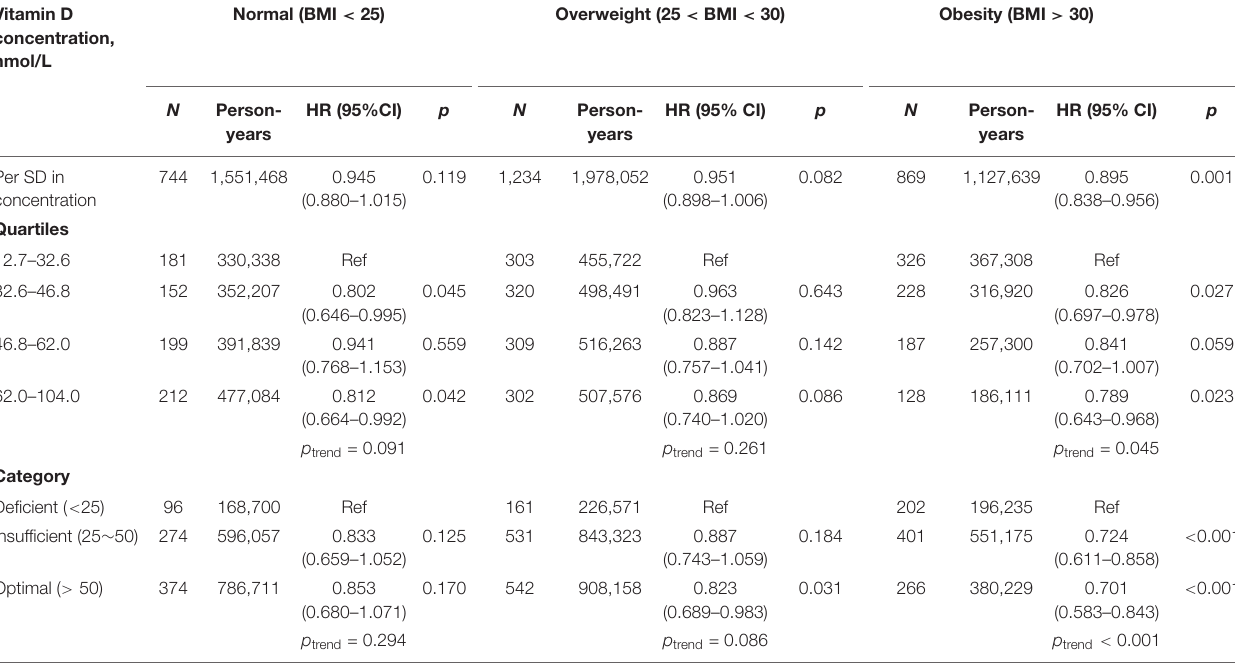
TABLE 3 | Association of vitamin D concentrations with incident psoriasis in different BMI categories. Vitamin D